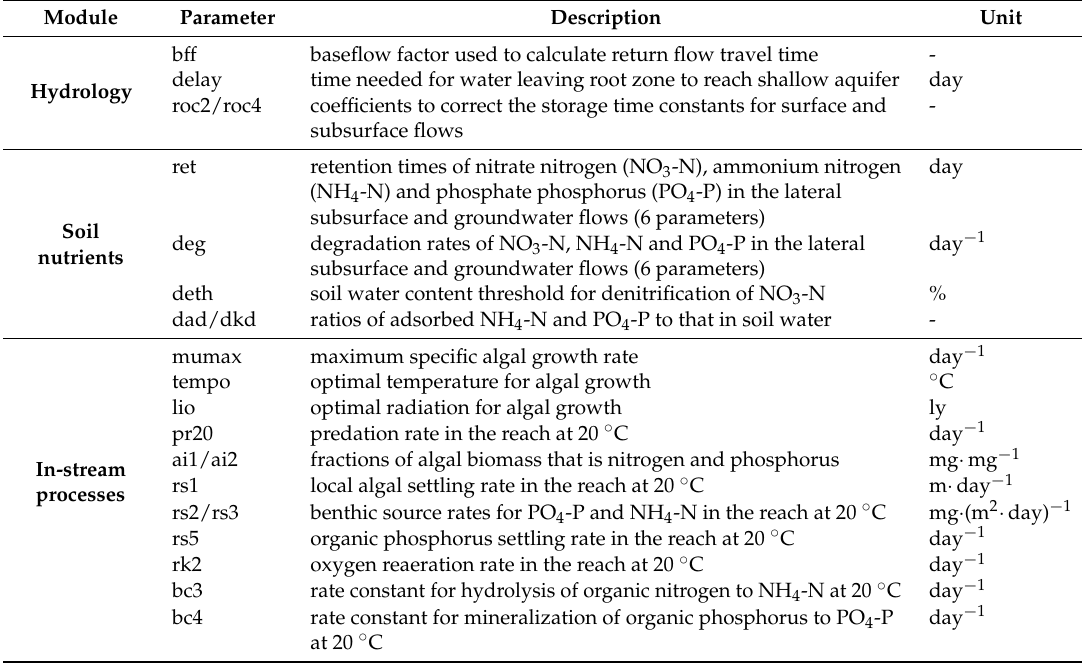
Table 2. SWIM calibration parameters applied spatially distributed in the Elbe river basin.